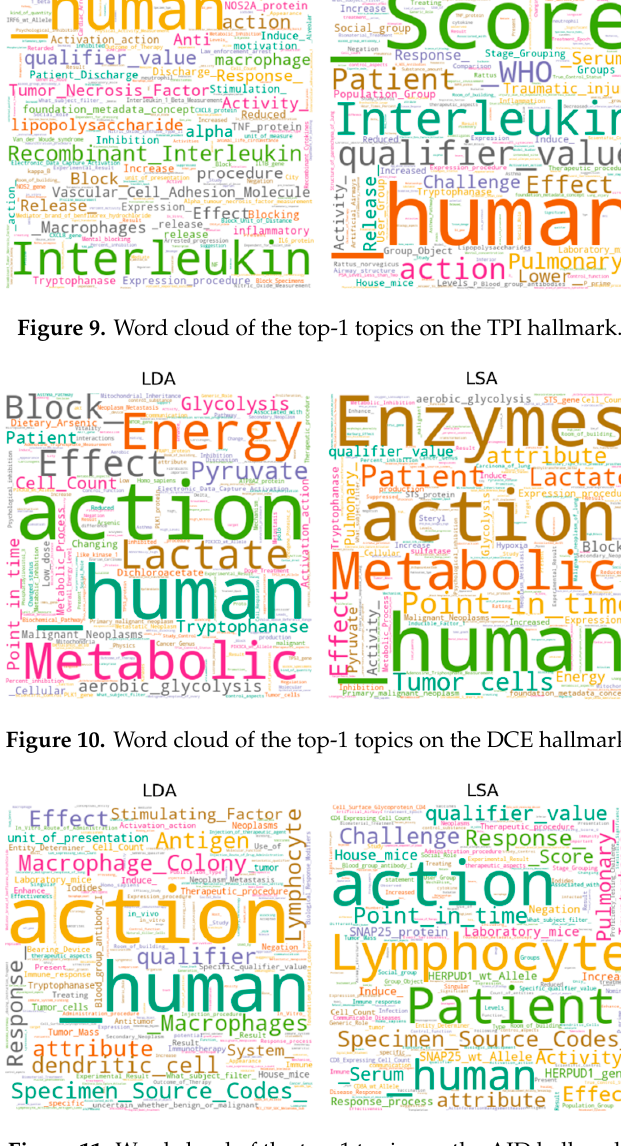
Figure 11. Word cloud of the top-1 topics on the AID hallmark.